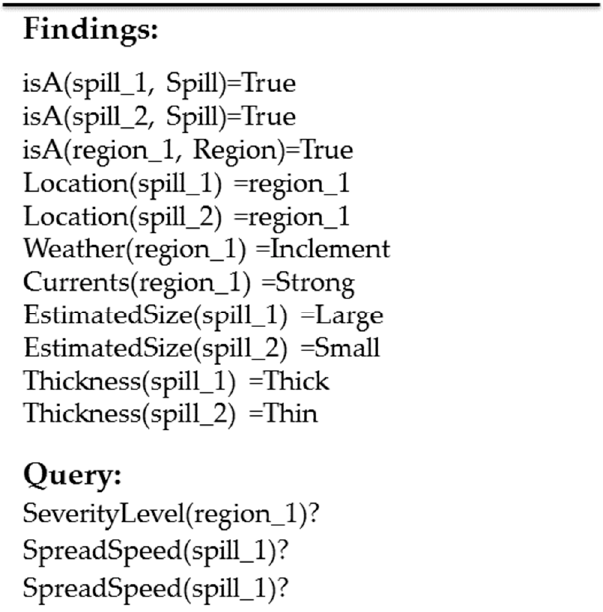
Figure 9. Findings in the scenario.